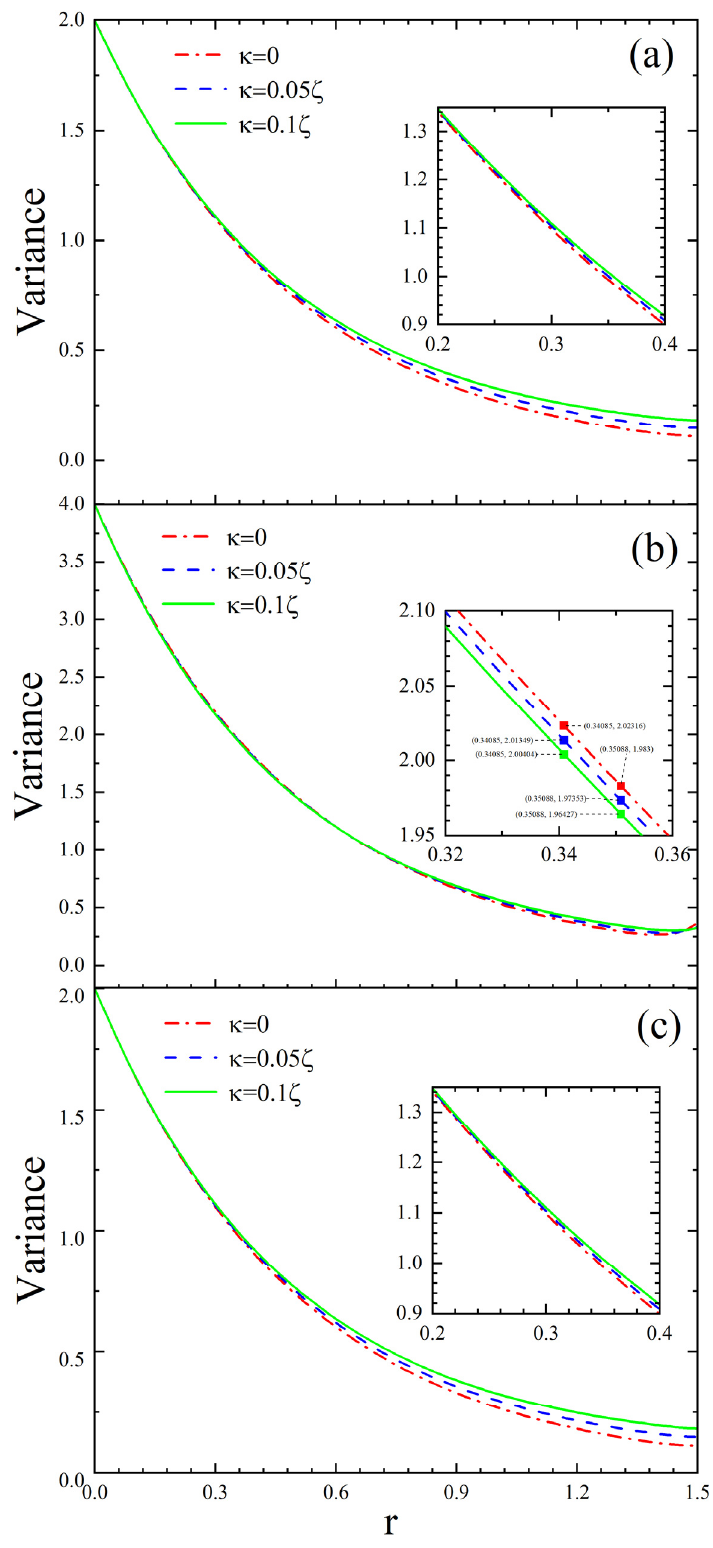
Figure 5. The total variance with different decay rates of the cavity κ versus squeezed strength r under the different initial conditions. ( a ) Initial two-mode vacuum state | 0 1 ,0 2 (cid:105) ; ( b , c ) initial two- mode odd/even coherent state N ∓ ( | α 1 , α 2 (cid:105) ∓ |− α 1 , − α 2 (cid:105) ) . Here κ 1 = κ 2 = κ , ζ = g 1 g 2 5𝑔 , 𝛼 (cid:2869) = 𝛼 (cid:2870) = 0.1 .